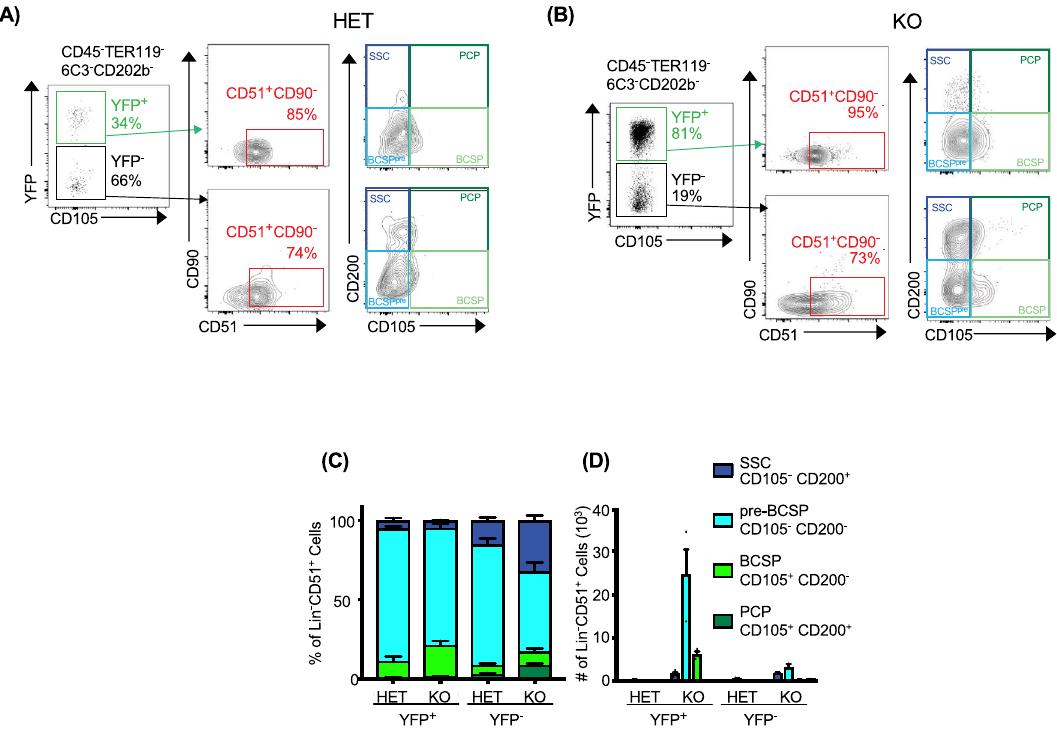
Figure 3. Increased YFP + tumor-associated cells have a bone chondrocyte stromal precursor (BCSP) cell phenotype. ( A , B ) Representative flow cytometry gating strategy for identifying cells isolated from adult wrists in Het and KO animals. Lineage negative cells (CD45 − , TER119 − , 6C3 − , CD202b − ) were first separated into YFP + and YFP − cell populations (green and black boxes, respectively). Each subset was then gated by CD51 (Alpha V integrin) and CD90 (Thy1.1) with CD51 + CD90 − cells (red box) being further subdivided into skeletal system stem cell phenotypes by CD105 and CD200 with the following assignments: SSC (CD105 − CD200 + , dark blue), pre-BCSP (CD105 − CD200 − , light blue), BCSP (CD105 + CD200 − , green), PCP (CD105 + CD200 + , dark green). Percentage ( C ) and total number ( D ) of each skeletal system cell phenotypes for YFP + and YFP − cells within both SHP-2 Het and KO animals (n = 3). Data are taken from one of two independent experiments and represent mean ± SEM. *p < 0.05, **p < 0.01, ***p < 0.001, and ****p <